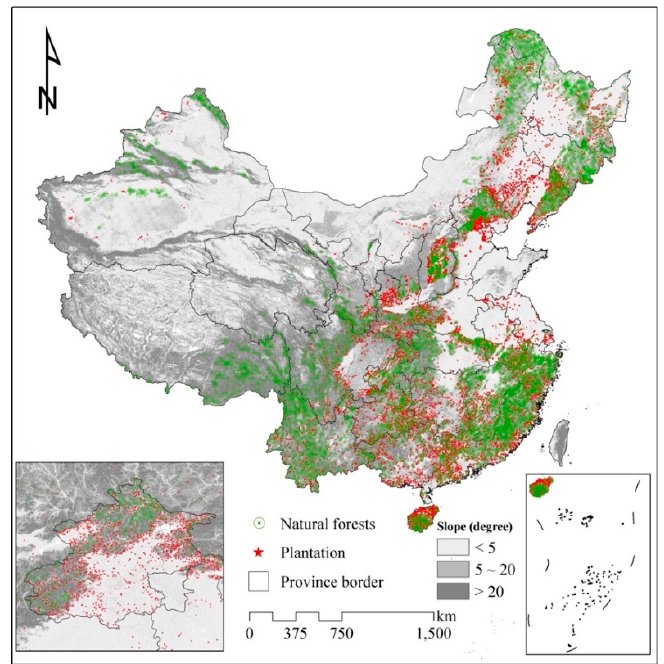
Figure 2. Sample distribution for natural forests and plantations. Differences in slopes are indicated from light gray to dark gray.